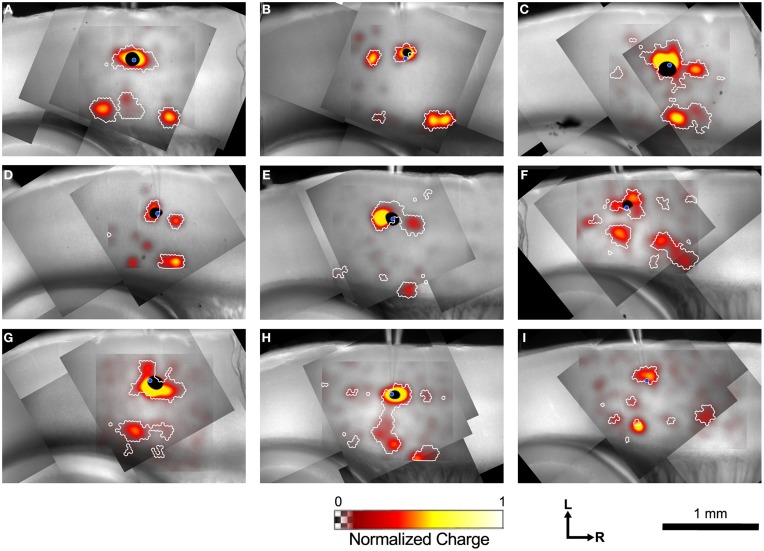
Example input maps from 9 L4 cells. (A–I) Each map is analyzed as described in Figure 3, and is represented in the format shown in Figure 3C. A blue circle in each map indicates the location of the patched cell. Note the discontinuous islands of input arising from locations rostral and caudal to the recorded cell.